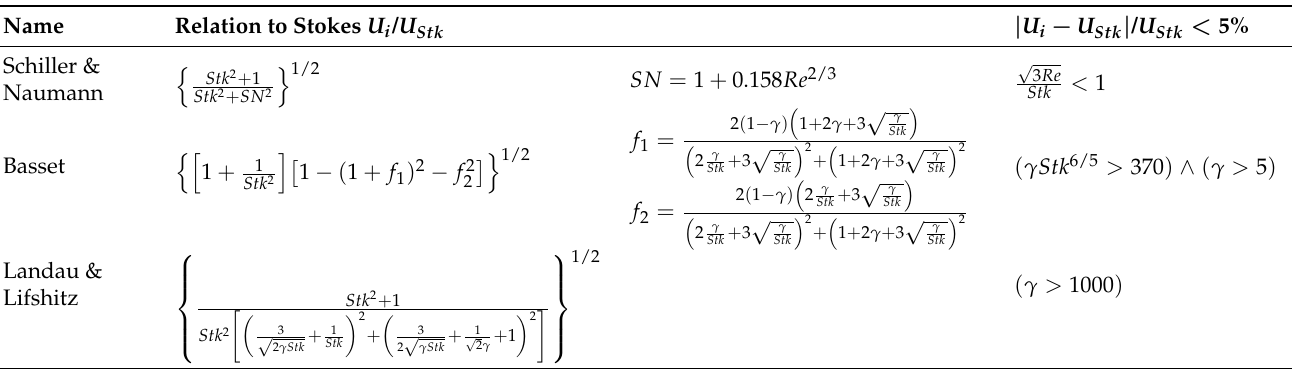
Figure 5. Areas where the deviation between Stokes and the respective drag model is above (blue— Schiller & Naumann, purple—Basset, green—Landau & Lifshitz) and below (red) 5%. In the red areas, the Stokes model can be applied in the validity range of the respective model. Table 2. Relations of the drag models listed in Table 1 to the Stokes model, expressed with the oscillation Stokes number Stk and the density ratio γ . Additionally, the limit is given up to which the deviation stays below 5%, in which case the Stokes model can be applied in the validity range of the respective model. Multiple criteria are set in relation to each other via the logic operator ∧